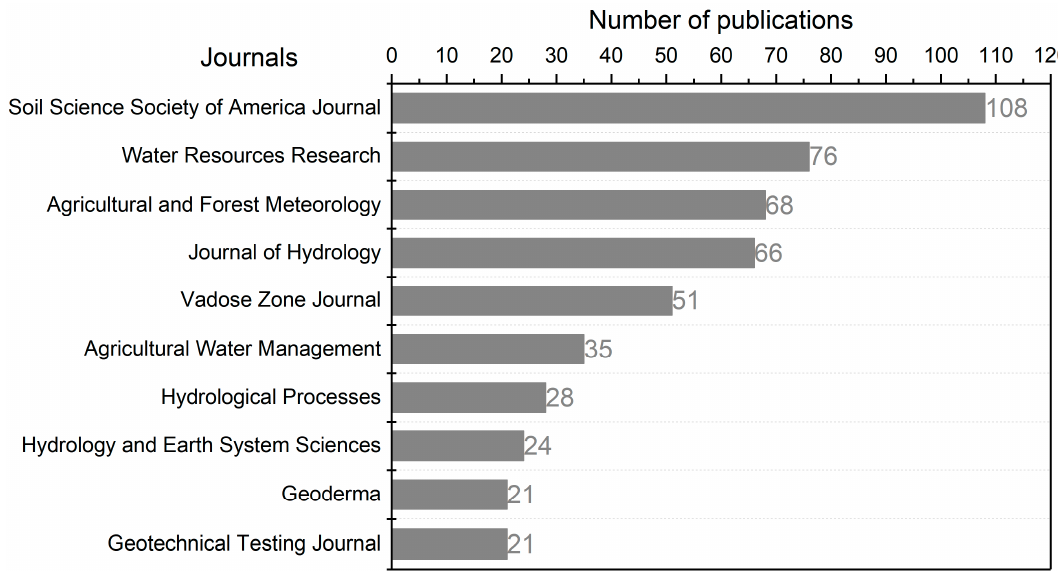
Figure 3. Top 10 journals publish research on heat pulse method for soil physical measurements.